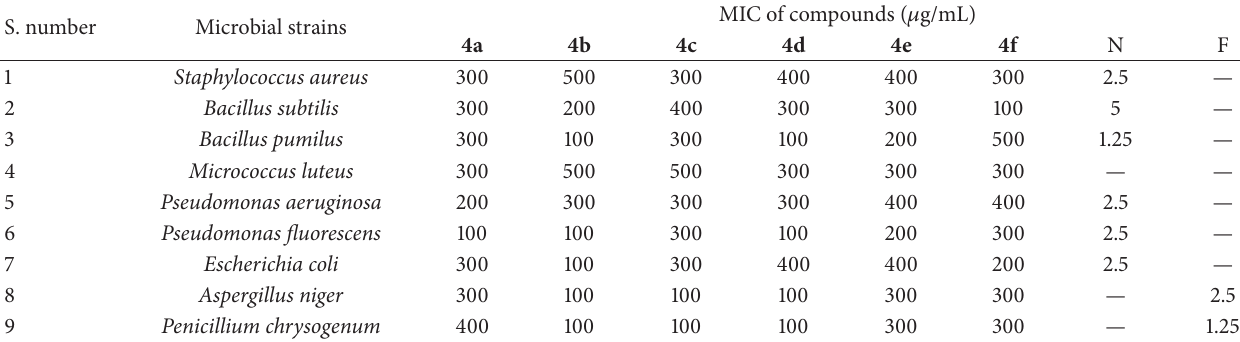
Table 3: Values of the minimum inhibitory concentration of the synthesized compounds and reference